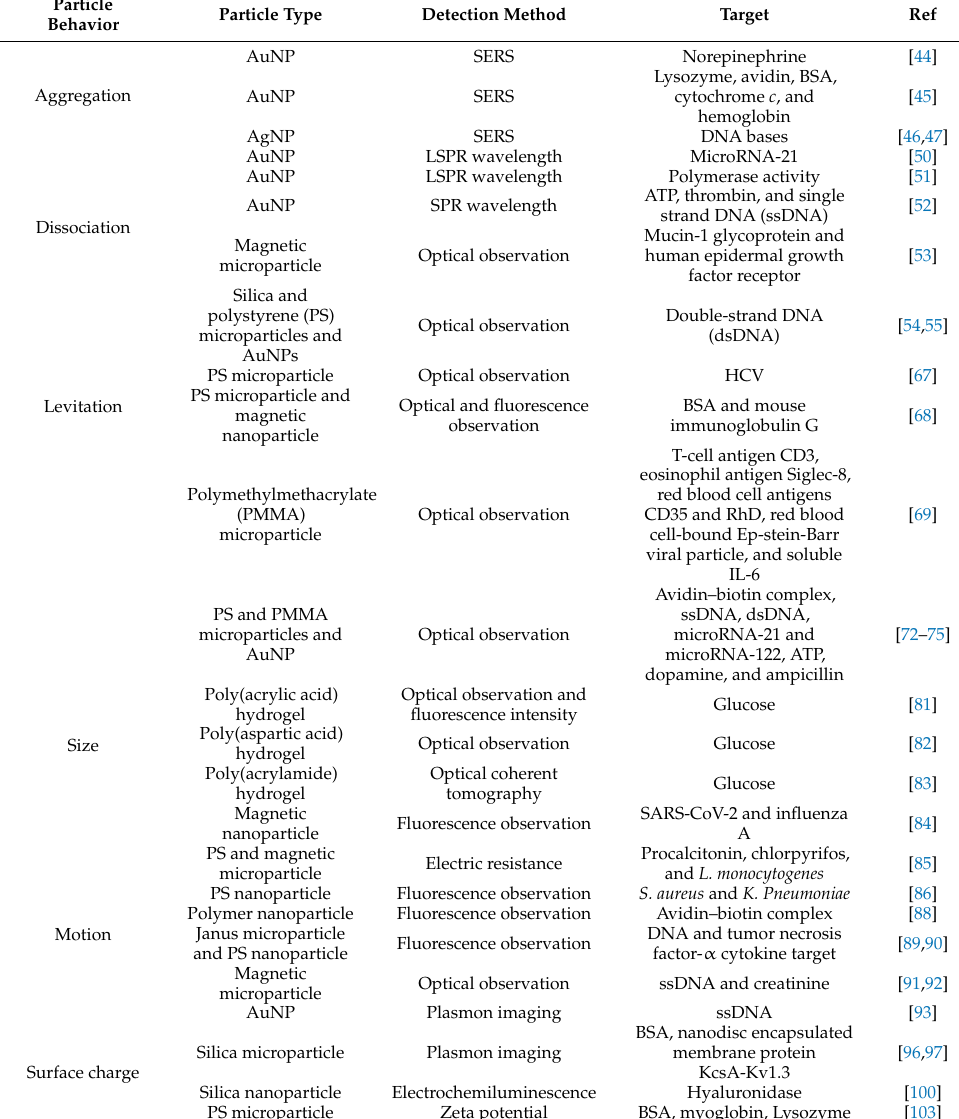
Table 1. Summary of biosensors based on the particle